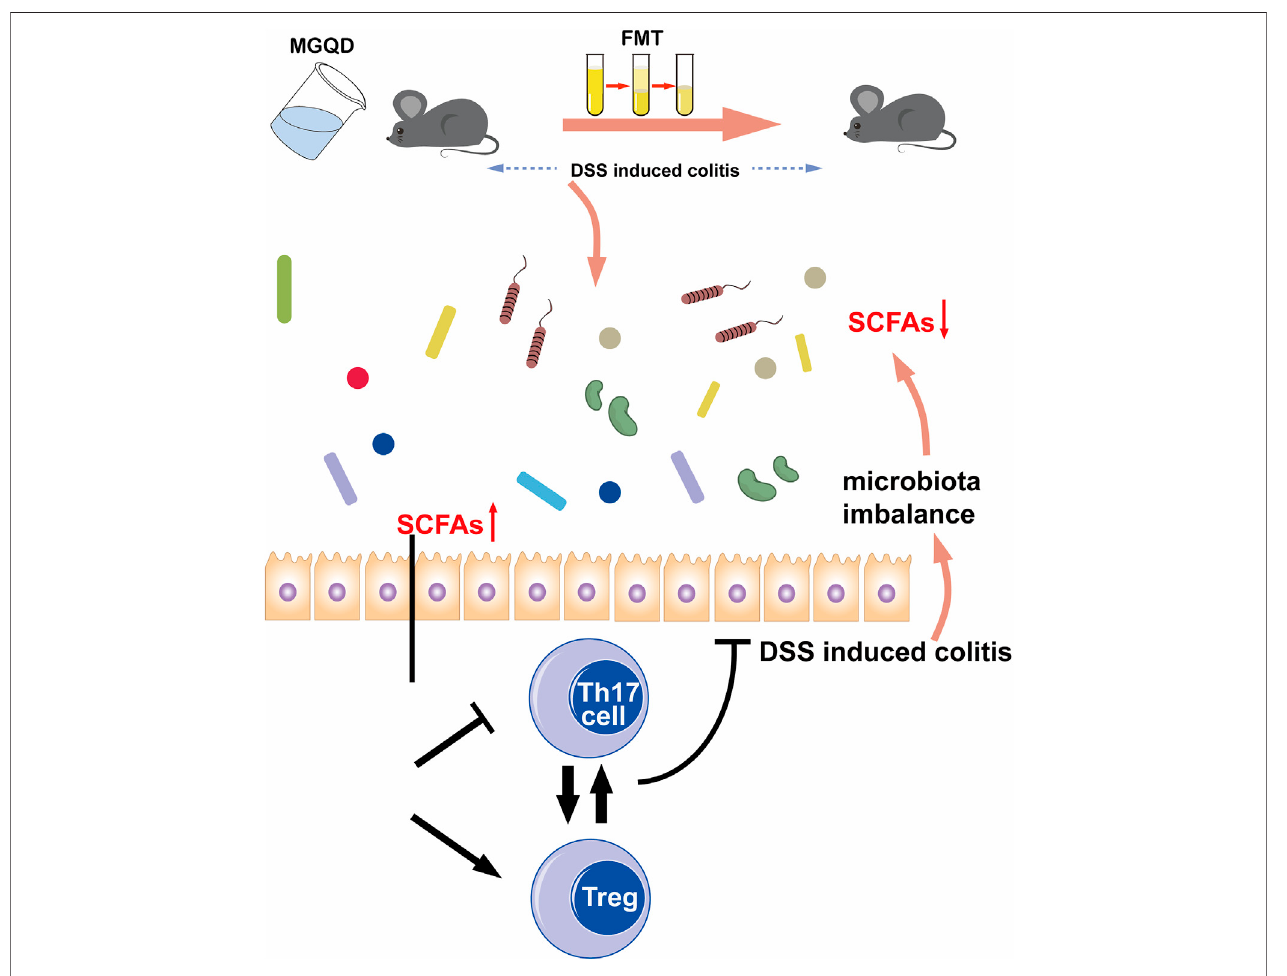
FIGURE 13 | Schematic illustration of the protective mechanisms of MGQD against DSS-induced experimental colitis via restoring Treg/Th17 balance modulated by enhanced microbiota-generated SCFAs production.